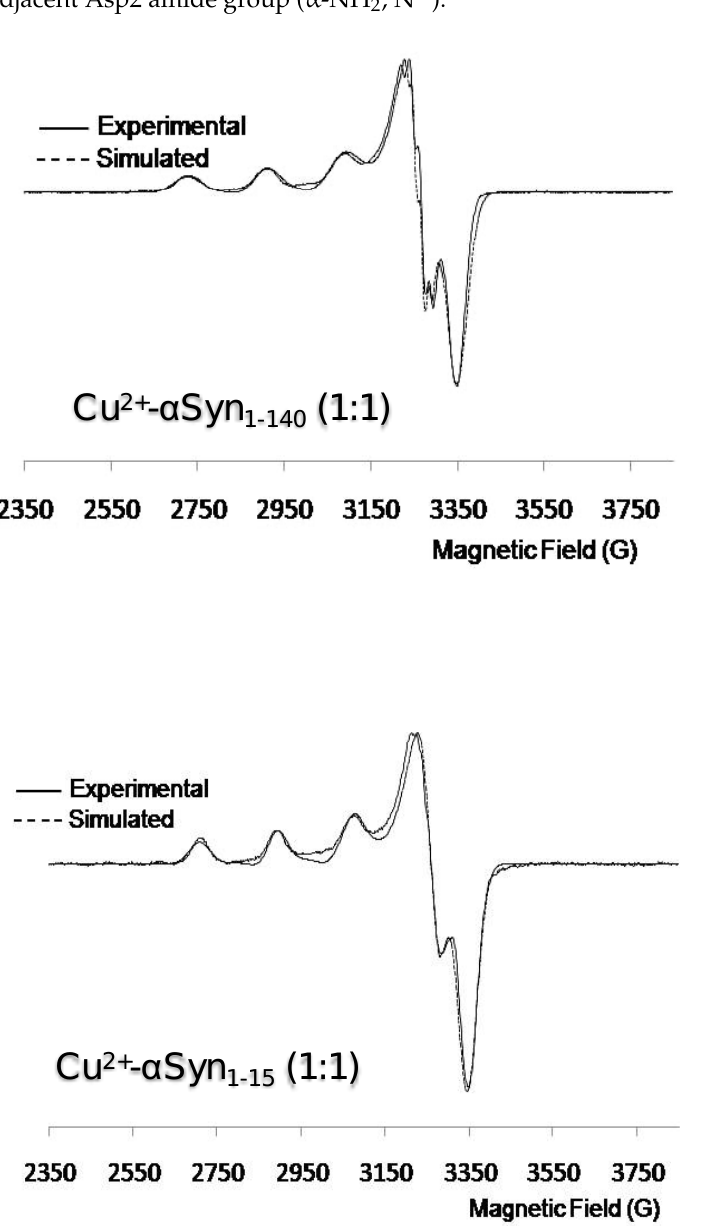
Figure 4. EPR spectra of micelle-bound synuclein Cu 2+ complexes: αSyn 1 – 140 (upper panel) and αSyn 1 – 15 (lower panel). αSyn 1 – 140 500 μM, αSyn 1 – 15 500 μM, Cu 2+ 500 μM, SDS 5 0 mM, phosphate buffer 20 mM pH= 7.4.